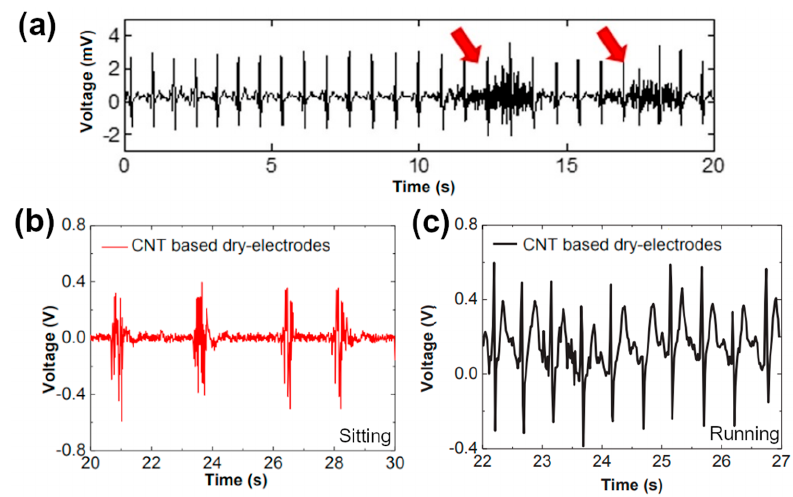
Figure 10. EMG signals acquired using CNT-based electrodes from ( a ) chest modified and repro- duced with permission from [168] Copyright The Authors (2014); and ( b , c ) forearm modified and reproduced with permission from [169] Copyright The Japan Society of Applied Physics (2018). Panels ( b ) and ( c ) demonstrate ECG signals while bending the arm during sitting and running, re-